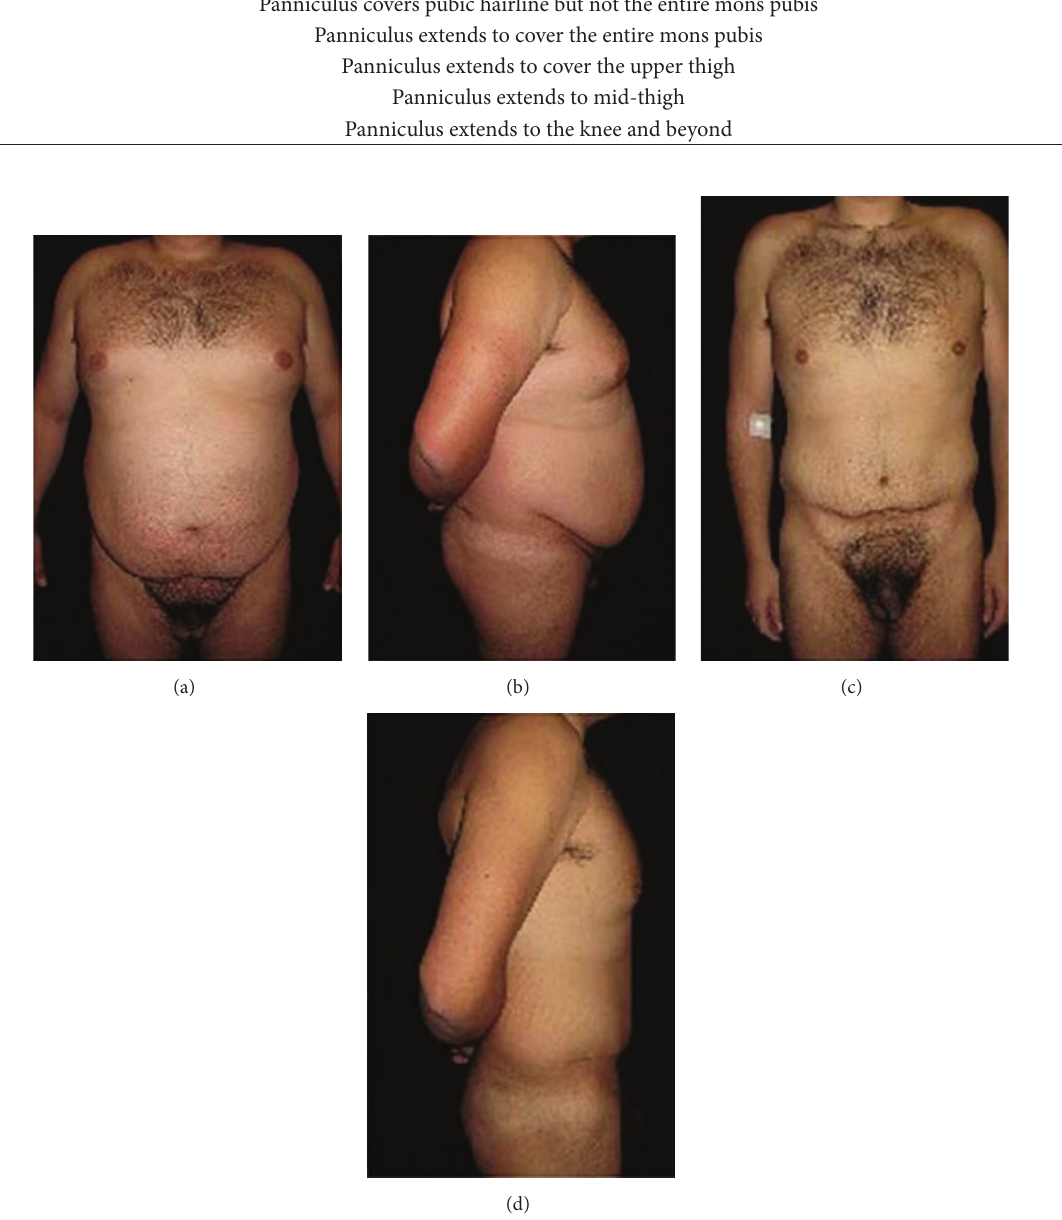
Figure 2: (a) Preoperative frontal view and (b) lateral view of a male patient (BMI = 44kg/m 2 ; body weight = 136 kg). (c) Postoperative frontal view and (d) lateral view five years after surgery (body weight = 73